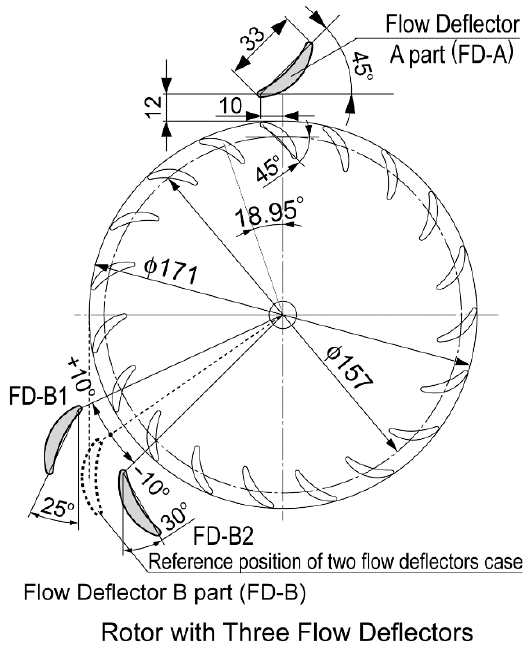
Figure 3. Cross-flow wind turbine with a casing having three flow deflectors.